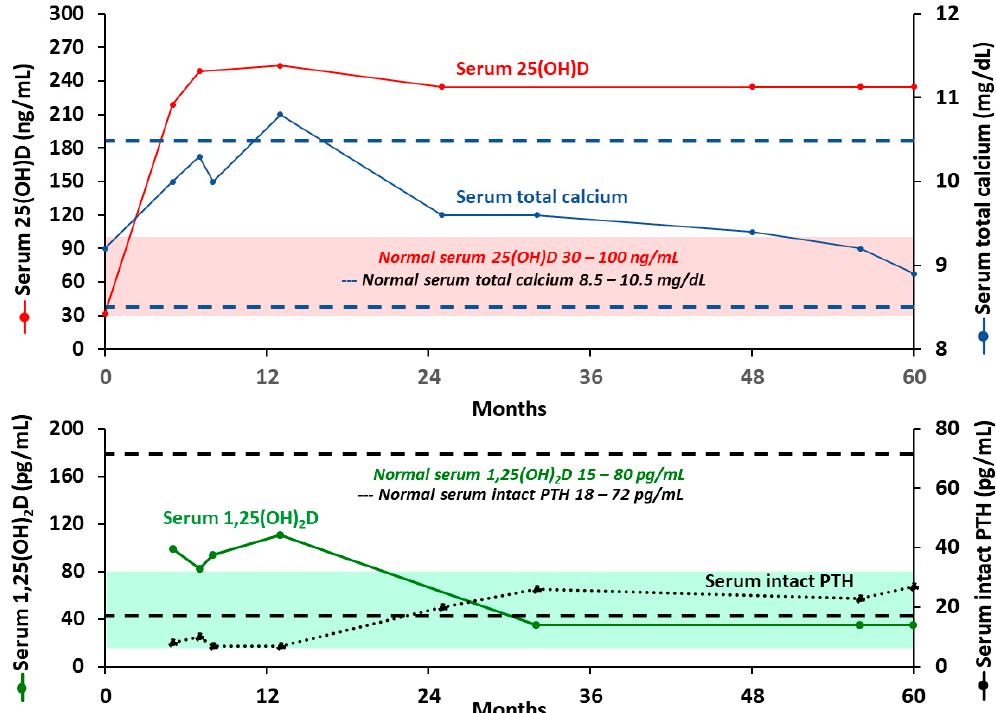
Figure 3. Biochemical measurements of a 52-year-old multiple sclerosis female who received 40,000 international units per day of vitamin D3 for 5 years. Abbreviation: 1,25(OH)2D: 1,25-dihydroxyvitamin D; 25(OH)D: 25-hydroxyvitamin D; PTH: parathyroid hormone. Note: Red solid line represents serum 25-hydroxyvitamin D levels. Blue solid line represents serum total calcium levels. Green solid line represents serum 1,25-dihydroxyvitamin D levels (15–80 pg / mL). Black dotted line represents serum intact parathyroid hormone levels (18–72 pg / mL). Red highlight represents normal range for serum 25-hydroxytamin D (30–100 ng / mL / 75–250 nmol / L). Green highlight represents normal range for serum 1,25-dihydroxyvitamin D (15–80 pg / mL). Blue dashed line represents normal range for serum total calcium (8.5–10.5 mg / dL). Black dashed line represents normal range for serum intact parathyroid hormone (18–72 pg / mL). Reproduced with permission from Holick MF, copyright 2020.